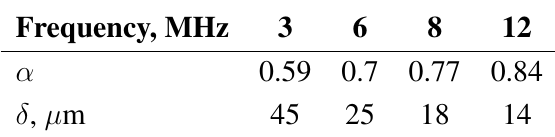
Table 1. Defined α and δ for four frequency reference